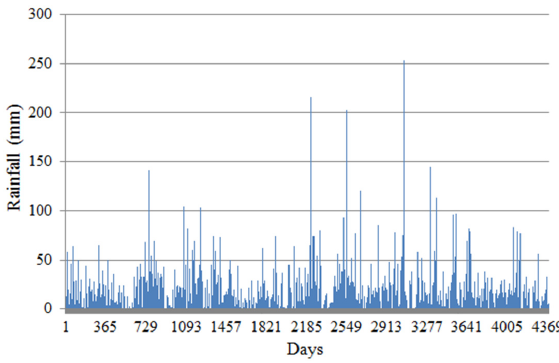
Figure 4. Daily rainfall in Florianópolis from 2002 to 2013.